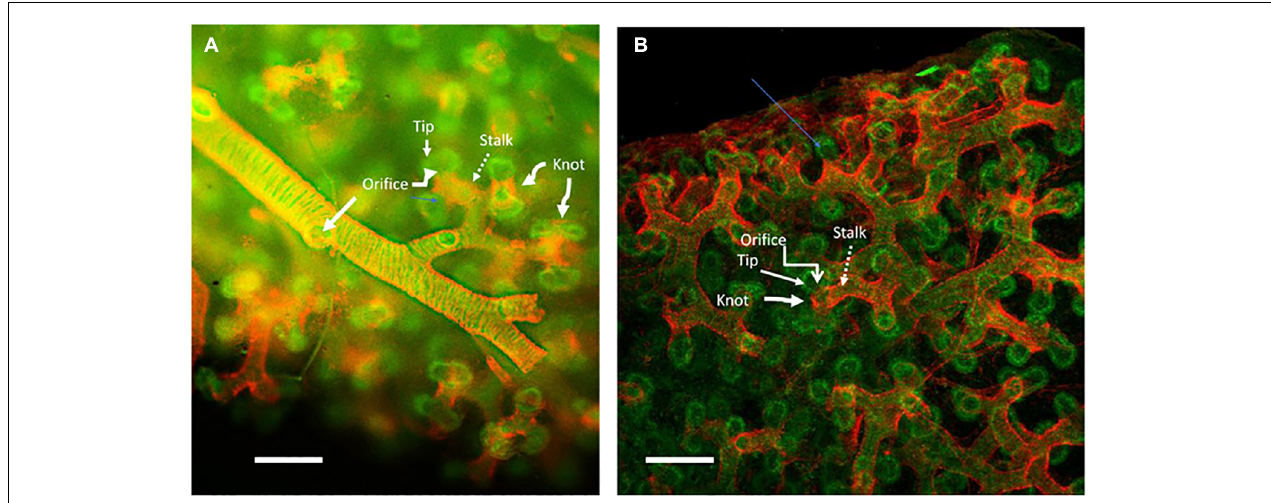
FIGURE 1 | Human lung aged 12 weeks gestation: whole mount specimen stained red for smooth muscle actin marking smooth muscle and green for e-cadherin marking the epithelium and imaged by confocal microscopy. (A) The smooth muscle actin (red) sleeve surrounding the peripheral stereotypically branching peripheral main airway epithelium (green) extending from left to tight across the panel. Round holes in the sleeve can be clearly seen where lateral branches arise (marked as Orifice). The sleeve of smooth muscle (marked as Stalk) extends outward toward the distal tips of the epithelium, whereat pairs of tips (marked as Tip) can be seen to extrude through round holes (Orifice) in the smooth muscle sleeve to make new peripheral epithelial branches. Smooth muscle knot-like structures between and around the peripheral tip branches are marked as Knot. (B) A more peripheral, juxta pleural view of the more peripheral branching process in the same specimen. The more proximal smooth muscle sleeve (Stalk), the peripheral holes in the sleeve (Orifice) where new branches. Also, the knot-like structure (marked as Knot) of smooth muscle that appears to divide and orient the specific planar direction of epithelial branch clefting and hence of tip extrusion. The plane of the pleura is at the top of the image. The images are adapted with kind permission from Danopoulos et al. (2020). Scale bars 100